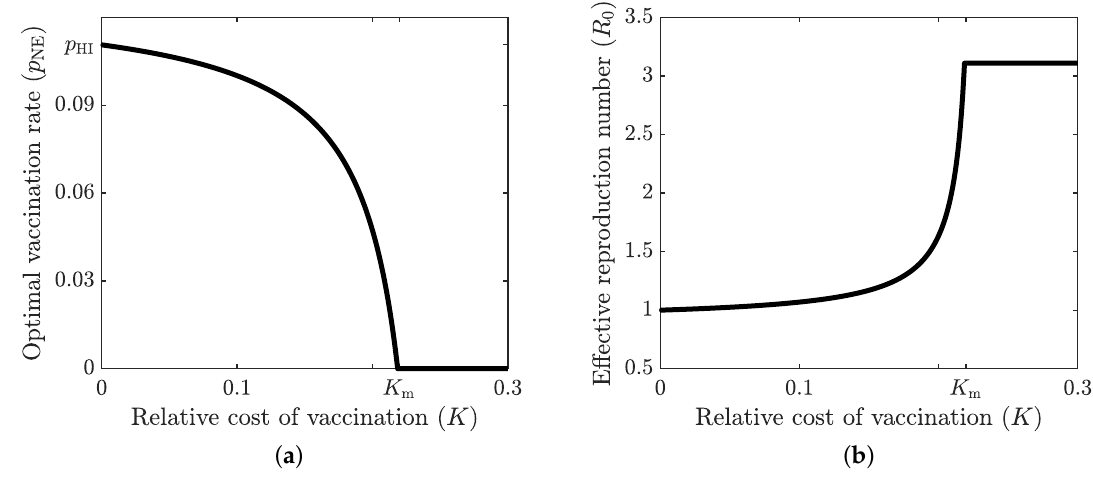
Figure 3. ( a ) The graph of optimal population vaccination rate p NE as a function of relative cost K . Note that p NE = p HI only when K = 0. ( b ) Variation in R 0 at the optimal vaccination rate as a function of relative cost K